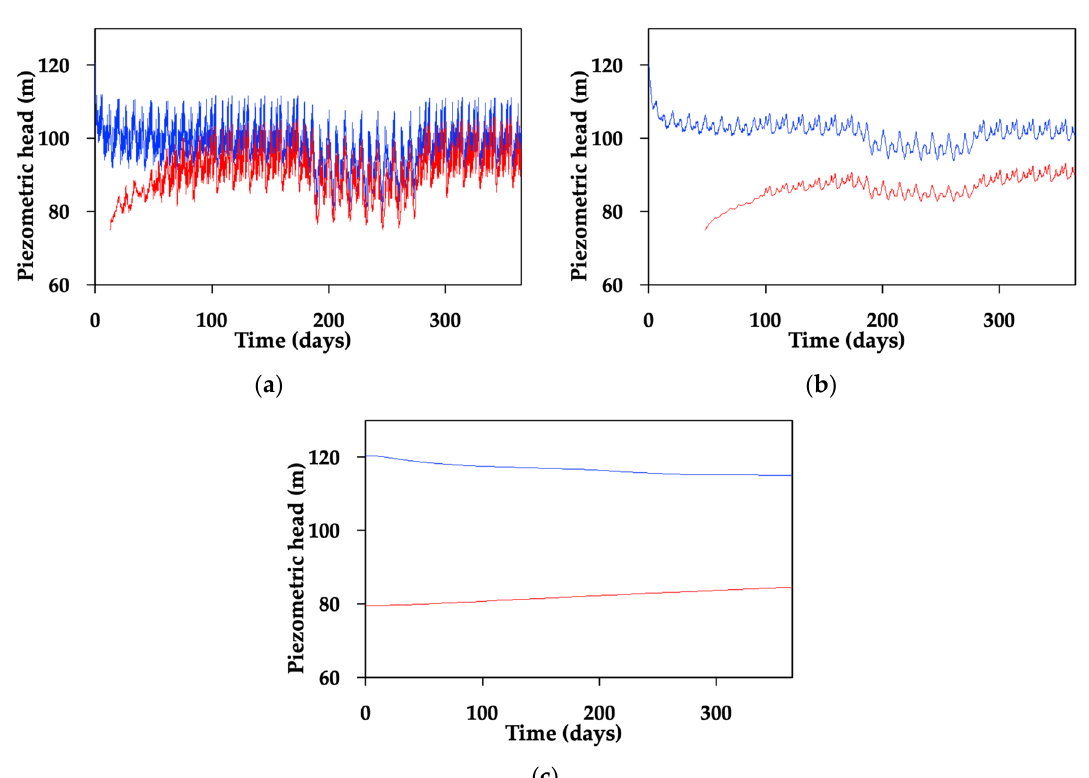
Figure 7. Piezometric head evolution at three observation points located at the downgradient side of the underground reservoir and at 105 m depth. Results of F-CI scenario are displayed in blue while those of E-CI scenario are plotted in red. The observation points are located at 5 ( a ), 15 ( b ) and 105 m ( c ) from the underground reservoir. The piezometric head is calculated taking as reference the bottom of the model, thus, the units are meters above the bottom of the model.